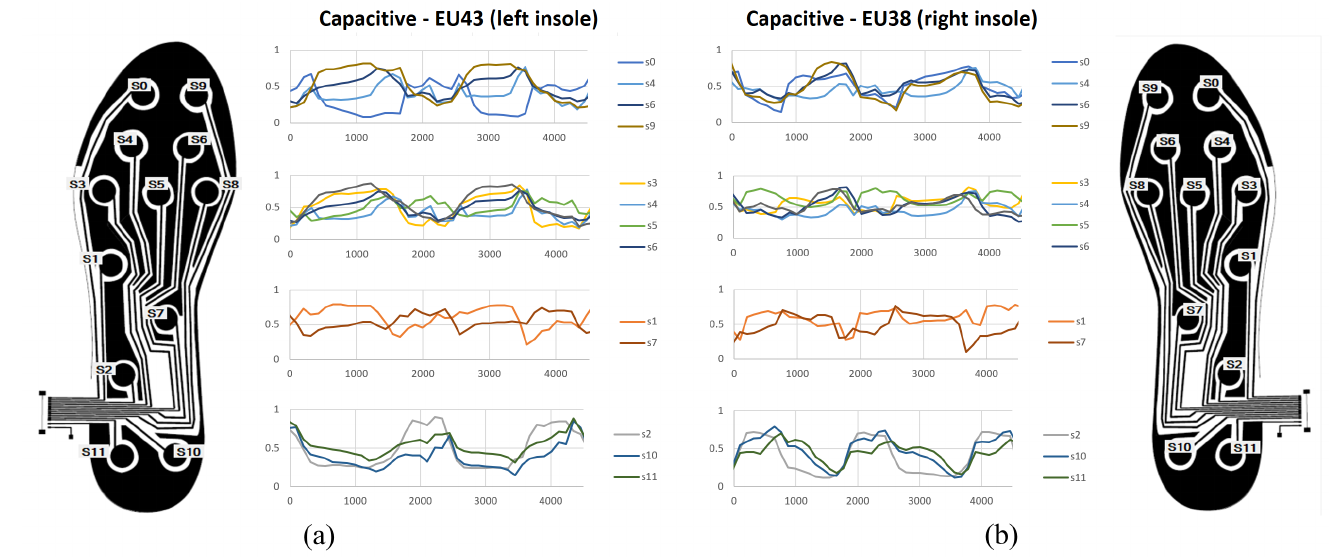
Figure 9. Behaviour during user gait—capacitive insoles. ( a ) EU43 size, left insole. ( b ) EU38 size, right